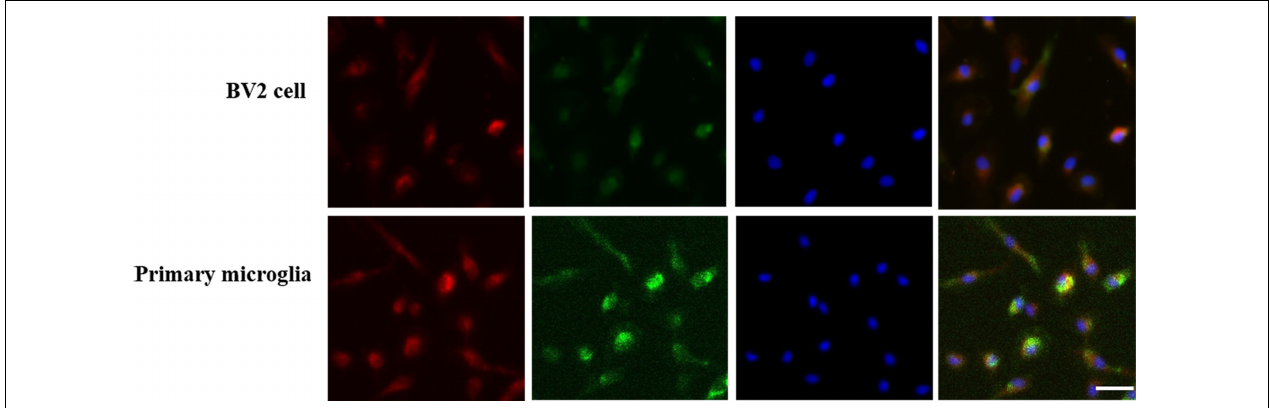
FIGURE 1 | G protein-coupled estrogen receptors co-localized with CD11b in BV2 cell and primary microglia. GPER was highly expressed in BV2 cell and primary microglia. Three-labeling immunofluorescence showed the co-localization of GPERs (red) with CD11b (green) and the cell nuclei (blue) in BV2 cells and primary microglia. Scale bar = 100 µ